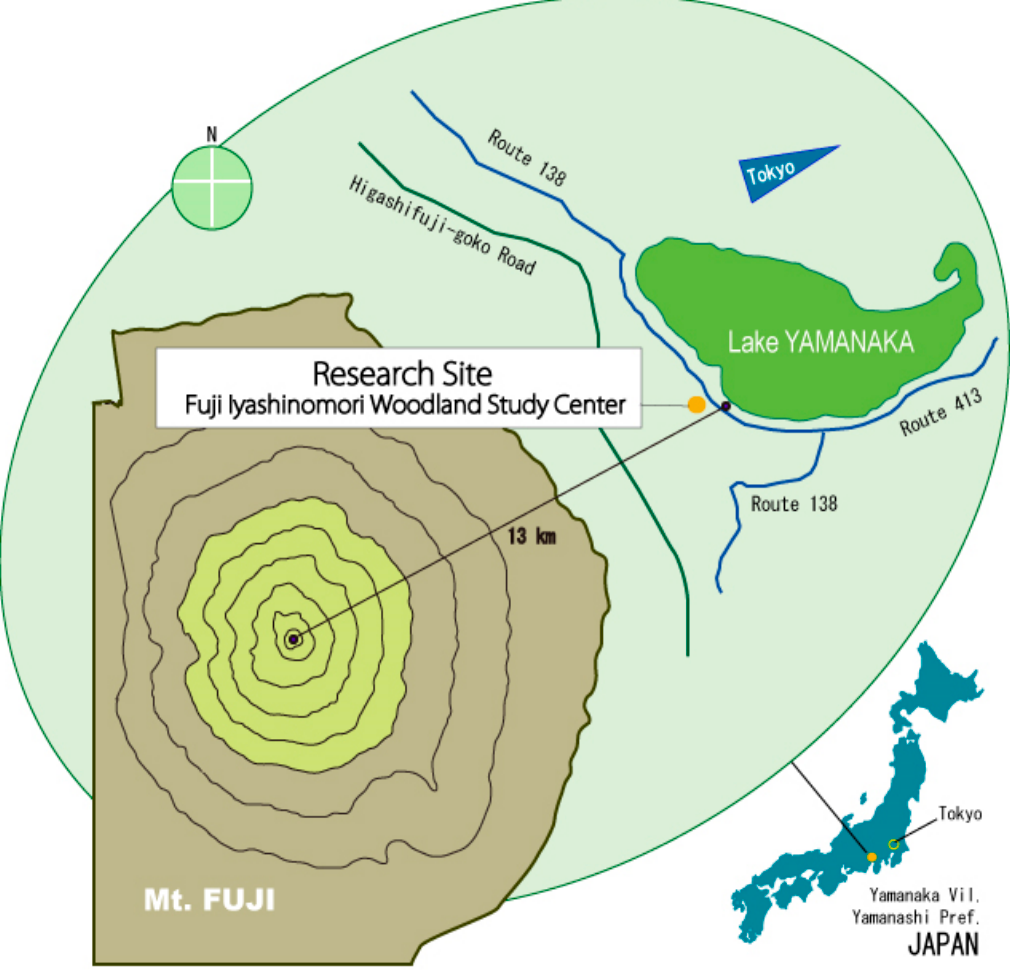
Figure 2. Locations of the research sites.